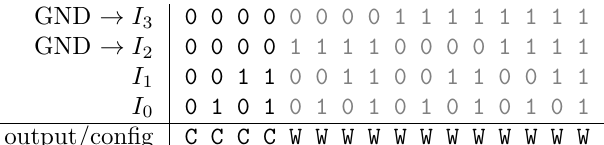
Figure 5: Example of a 4-to-1 bit LUT configuration where the C bits are actual configura- tion and the W bits can be used for